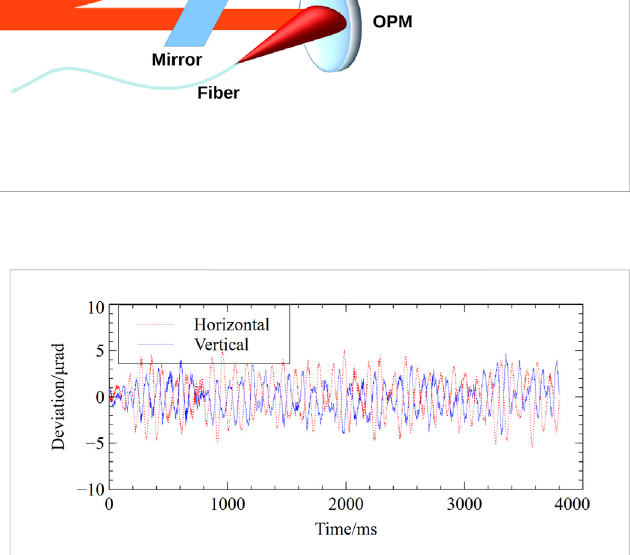
FIGURE 4 Beam-pointing fl uctuations of the SGII-UP-Petawatt – picosecond